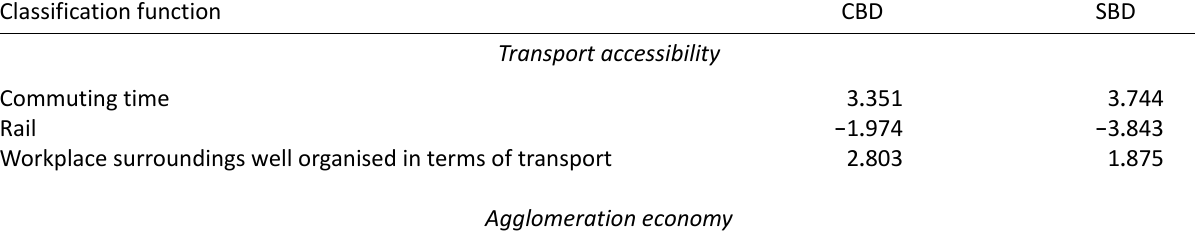
Table 2. Classification functions of the discriminatory model. Classification